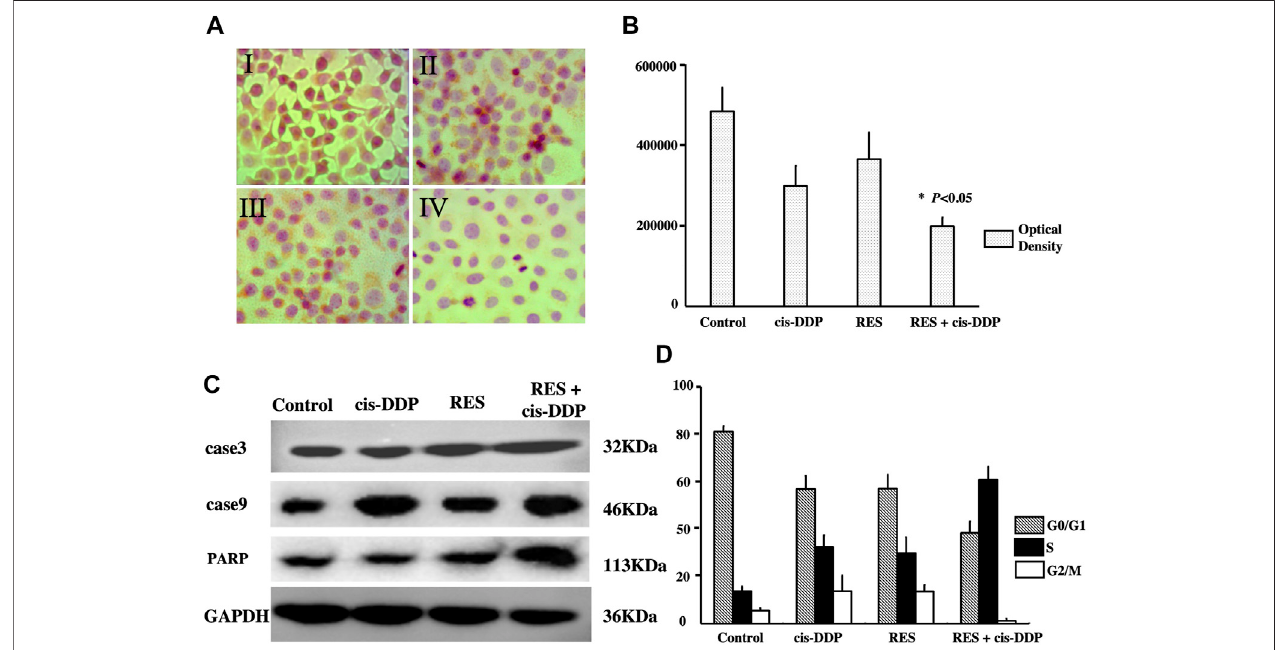
FIGURE 1 | RES + cis-DDP enhanced apoptosis in SiHa cells by inhibition of cell proliferation and S cell cycle arresting. (A) Images of proliferating cell nuclear antigens(PCNAs)inSiHa cellsbytheIHCmethod. I,II,III,and IVrepresentvehicle control,cis-DDP,RES,and RES+cis-DDP,respectively. PCNAs weredarkred spots in the nucleus. (B) Expression of PCNA by the IHC method was recorded as optical density, and it showed RES + cis-DDP signi fi cantly reduced the PCNA expression compared with other groups (* p < 0.05). (C) Expression of PARP and cleaved caspases 3 and 9 in each group was evaluated by Western blotting, and RES + cis- DDPcausedaconsiderableincreaseintheexpressionofPARPandcleavedcaspases3and9amongallgroups. (D) ImpactofthetreatmentsonthedistributionofSiHa cells in cell cycle phases was assessed by FACS. RES + cis-DDP increased the percentage of the SiHa cells in the S phase of the cell